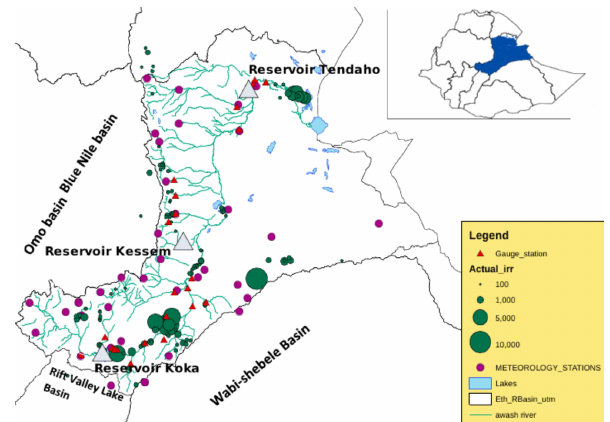
Figure 1. Map of Awash River Basin, highlighting the reservoir system and the local irrigation projects (adopted from Gebretsadik, 2015).